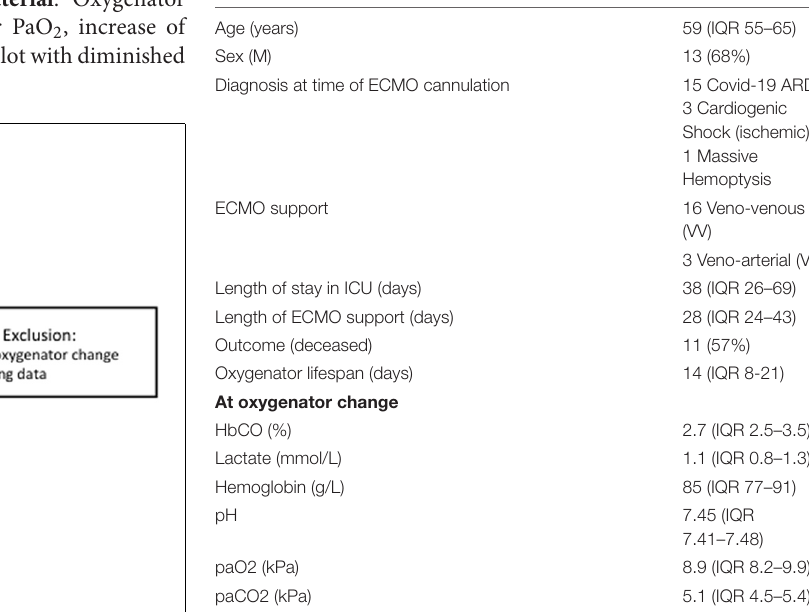
TABLE 1 | Population